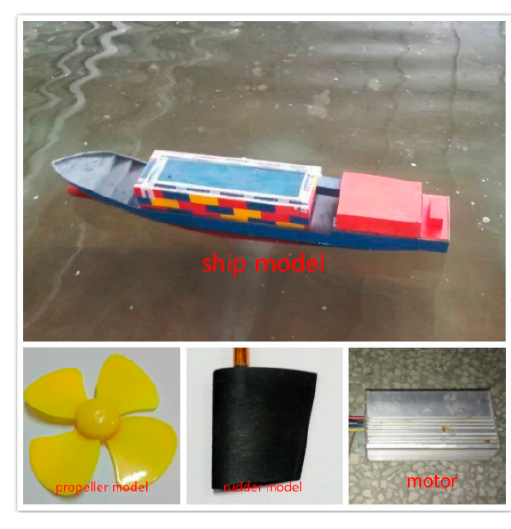
Figure 7. Ship model. Table 1. Primary parameters of the ship.